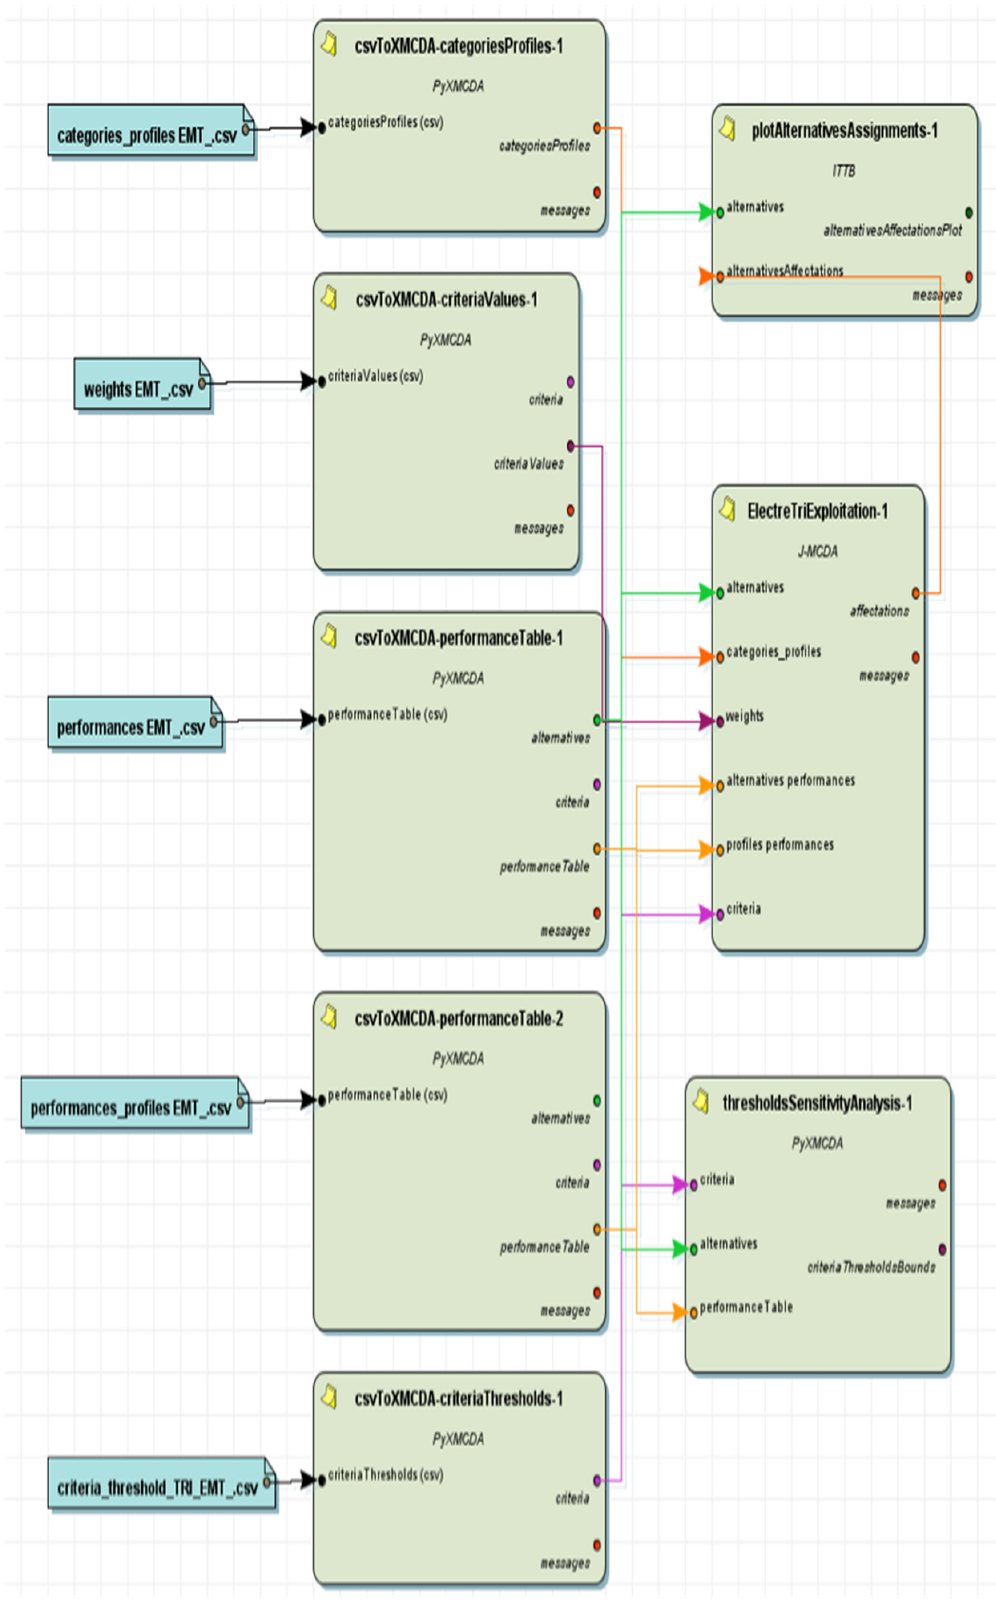
Figure 4. The workflow implementing ELECTRE TRI.